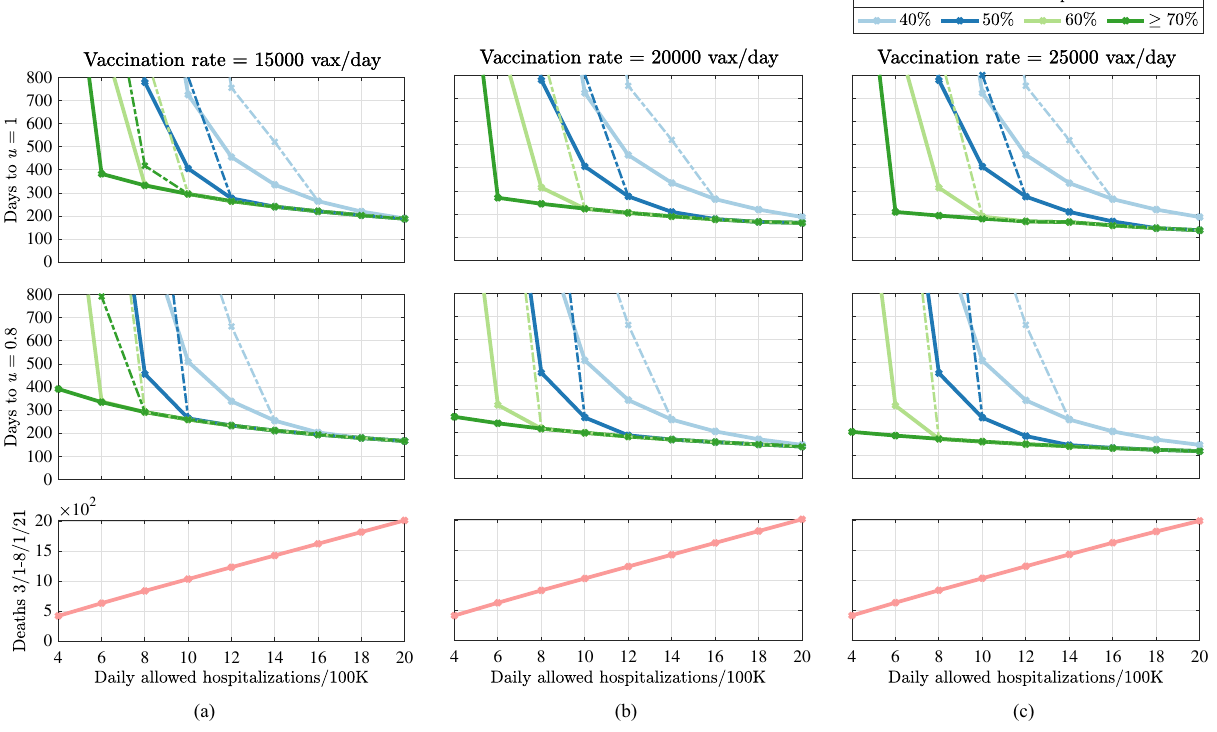
Figure 3. Number of days needed before a return to normal can be implemented without exceeding predefined hospitalization limits. The number of days is counted beginning 03/01/21. Continuous lines illustrate counts when models are not affected by variants. Dashed lines illustrate counts when models are affected by a variant whose effect is to double the transmission rate on 12/21/21. (Top row) Number of days to u = 1 . (Center row:) Number of days to u = 0.8 . (Bottom row) Estimated number of deaths between 03/01/21, and 08/01/2021. All simulations are conducted by using a single-compartment model fitted using data from the state of Colorado, USA (see “Methods” section). Any vaccination uptake of 70% or larger yields an identical (dark green)